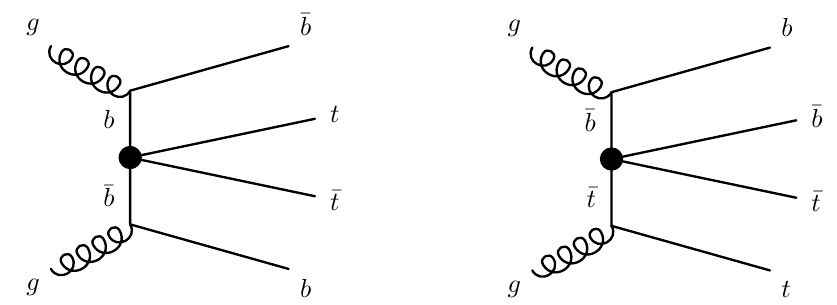
Figure 1 . Dominant EFT contributions to t (cid:22) tb (cid:22) b